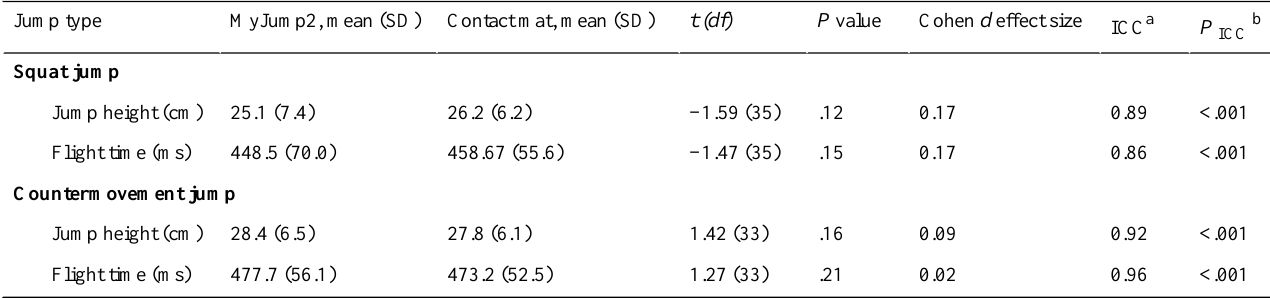
Table 1. Values of absolute comparison and intraclass correlation coefficient between the instruments for the jump height and flight time of squat jump and countermovement